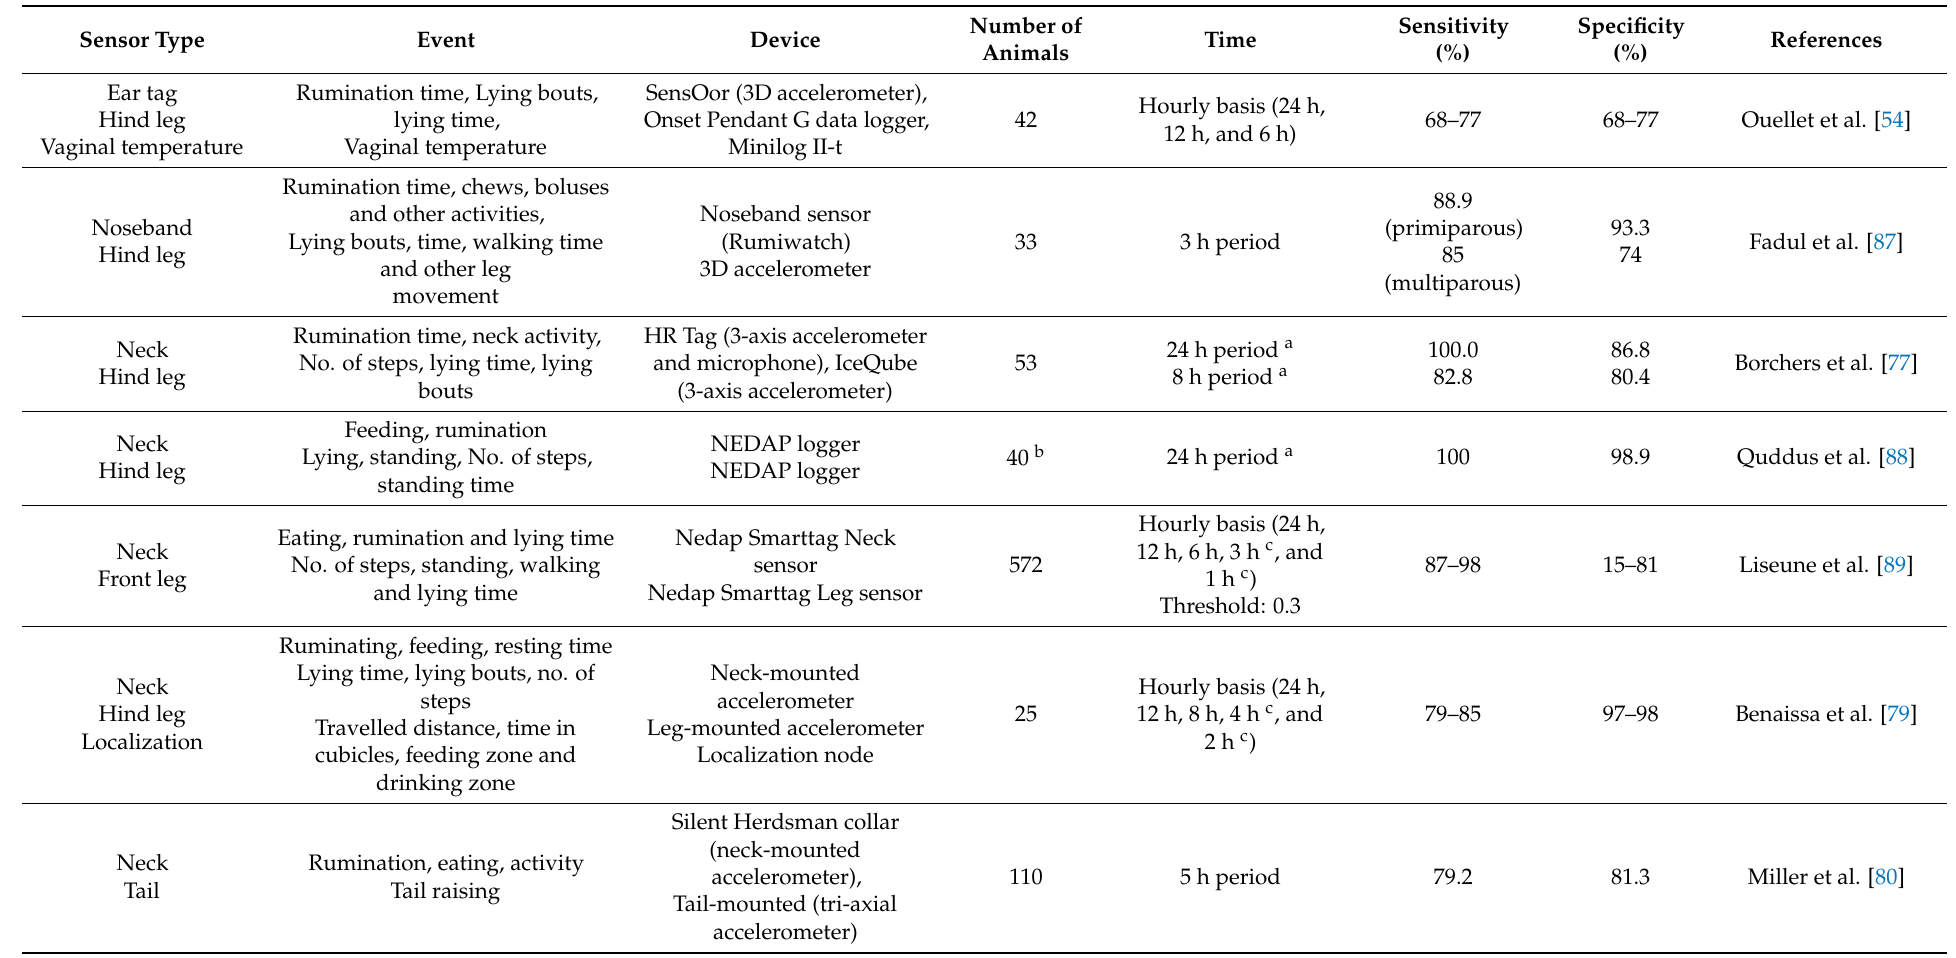
Table 4. Accuracy to predict calving by evaluating the behavioural signs of imminent calving by using a combination of